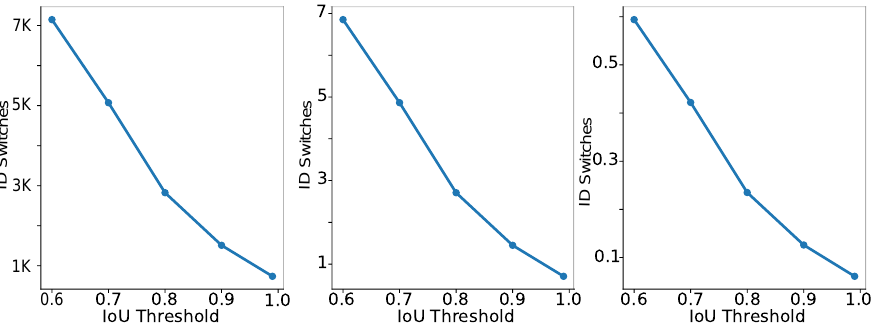
Figure 6. ID Switches versus IoU thresholds in DeepSORT. From left to right: total, average per person, and average per detection ID